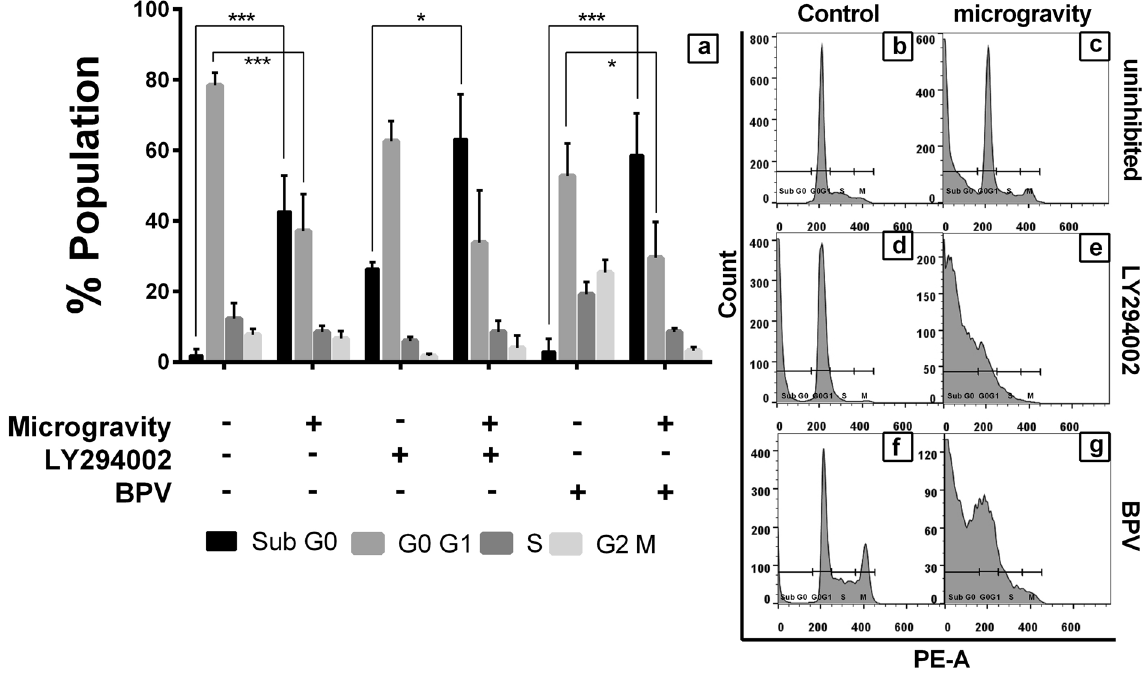
Figure 7. Cell cycle analysis of AKT/PTEN inhibited cells subjected to SM. The graphical representation of the population distribution of DLD1 cells across various stages of cell cycle during SM and SM after inhibition of AKT (LY294002 10 μ M) or PTEN (bpV(HOpic) 14 nM) ( a ). The data is represented as mean + S.D. The representative histogram of PI intensity for control DLD1 ( b ), SM ( c ), AKT inhibition ( d ) and SM after AKT inhibition ( e ), PTEN inhibition ( f ) and SM after PTEN inhibition ( g ) shows clear shift in the PI intensity with each